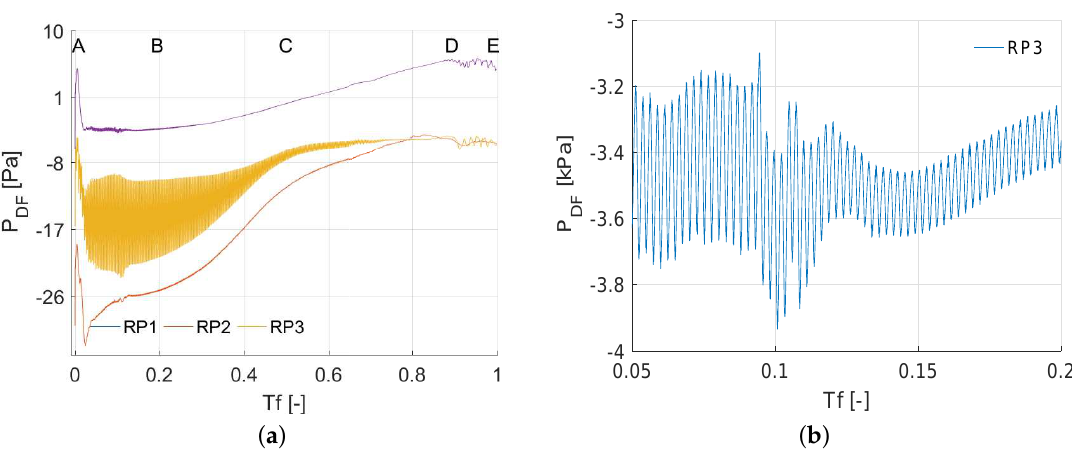
Figure 13. ( a ) Evolution of the pressure values during the considered time at the inlet of the draft tube. ( b ) Detailed representation of the oscillations at point